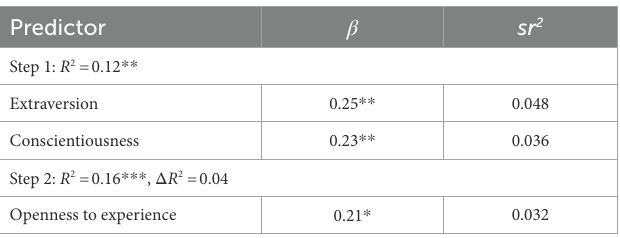
TABLE 2 Hierarchical regression results for effects of personality predictors on work creativity (extraversion and conscientiousness at Step 1; openness at Step